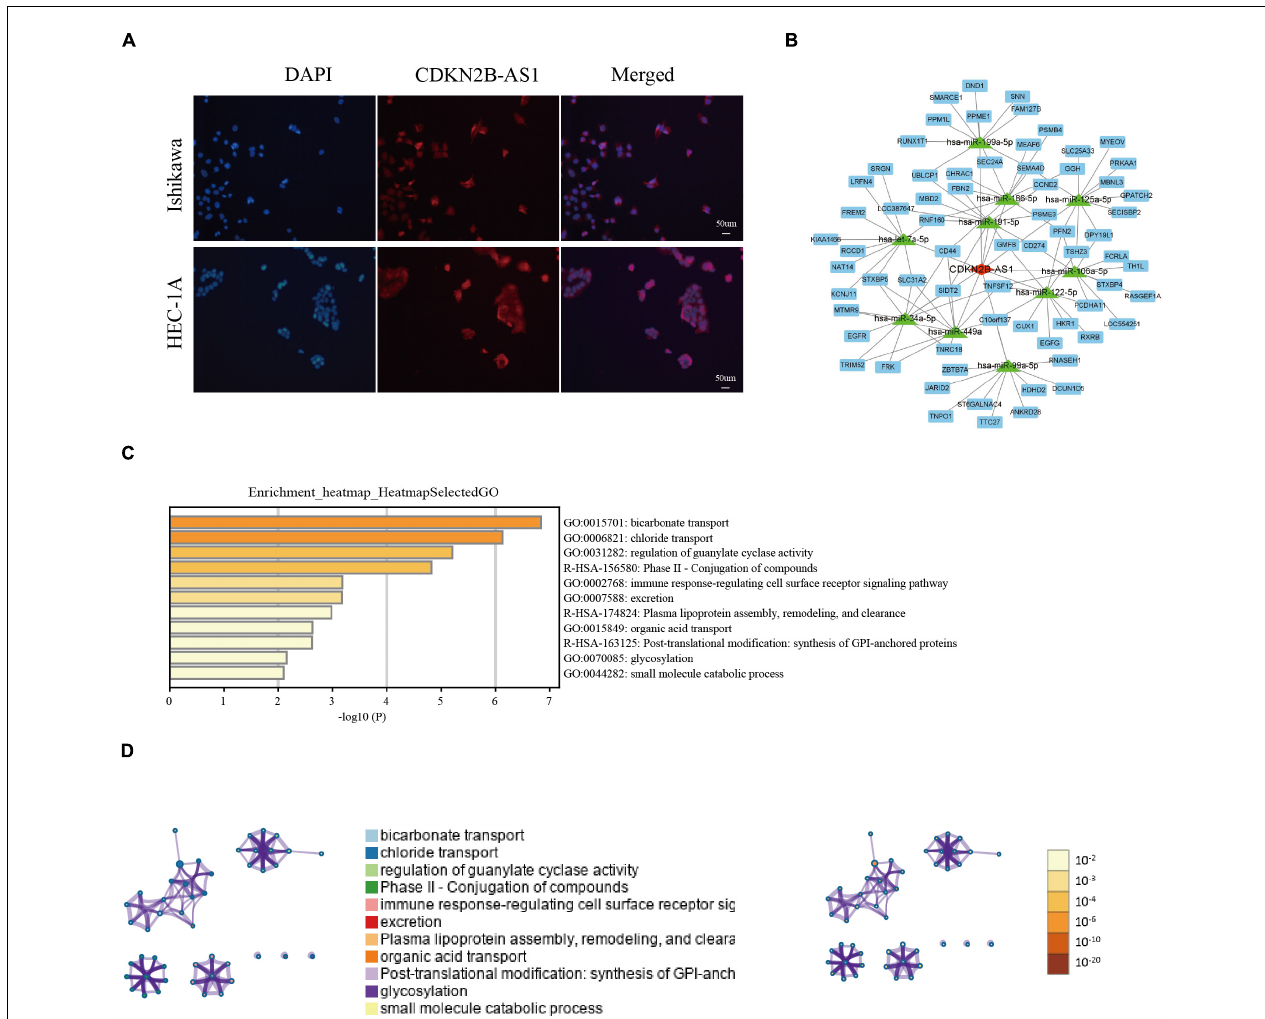
FIGURE 9 | CDKN2B-AS1 cellular location, lncRNA–miRNA–mRNA regulatory network, and GSEA results. (A) FISH assay of CDKN2B-AS1 localization in Ishikawa and HEC-1A cells. (B) CDKN2B-AS1-binding miRNAs were predicted using STARBASE and their targets were retrieved from miRTarBase. The regulatory network of lncRNA-miRNA-mRNAs was visualized using Cytoscape 3.7.1. (C,D) Biological processes related to